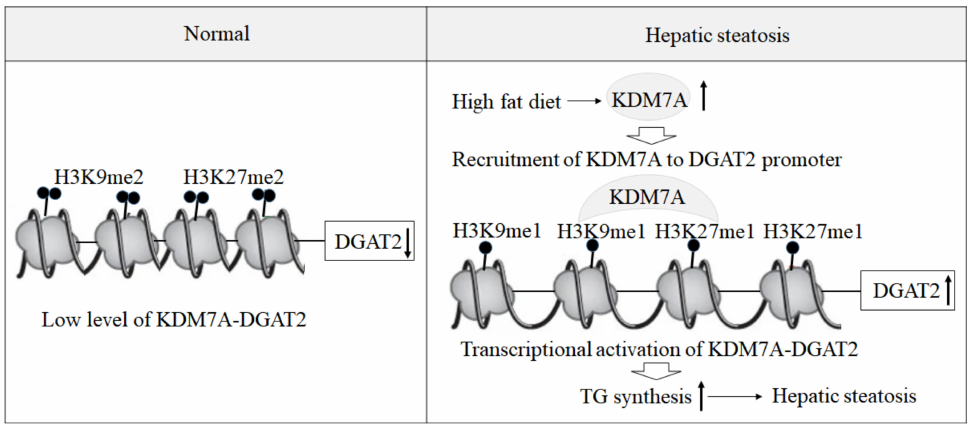
Figure 6. A proposed epigenetic model of KDM7A-DGAT2 in the development of hepatic steatosis. Up arrow means upregulation and down arrow means